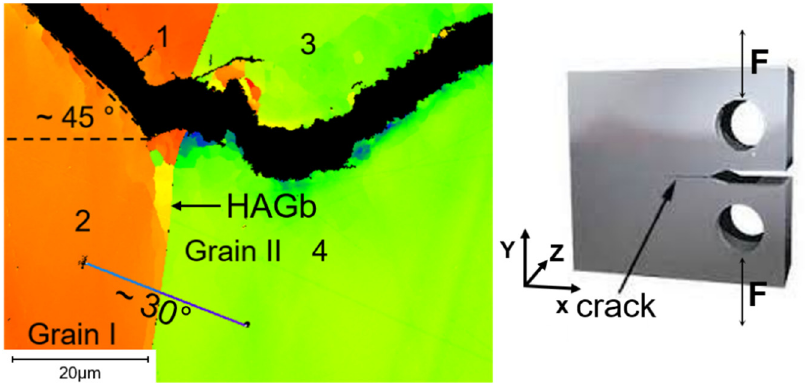
Figure 11. EBSD images show the positions of Schmid factor determination along the fracture path before and within a “plateau” region and corresponding misorientation angles between grains I and II (cf. Figures 7 and 10b).